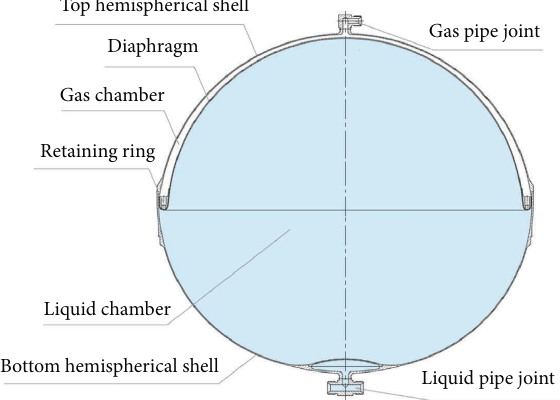
Figure 1: Schematic diagram of a diaphragm tank.